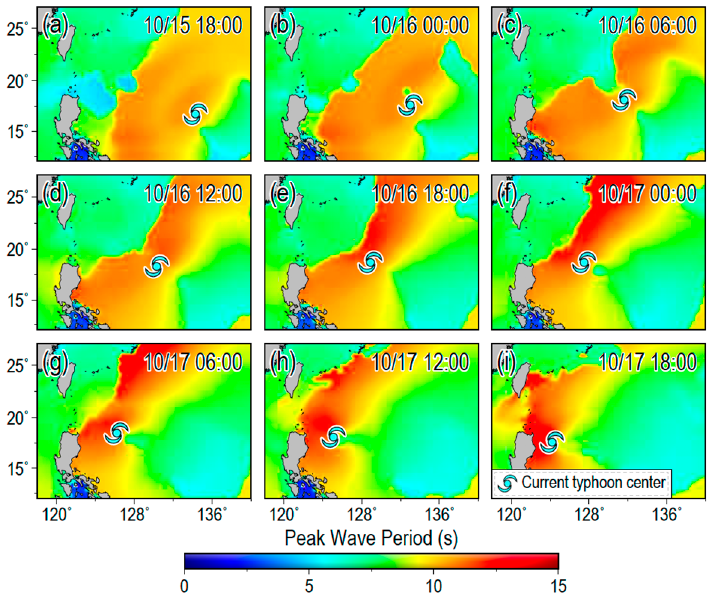
Figure 4. Analysis of the propagation and dispersion of ocean swells induced by Typhoon Megi. The distribution of peak periods of ocean waves in 6-h time intervals on 15–17 October 2010 ( a – i ) was predicted by ERA5 reanalysis from the European Centre for Medium-Range Weather Forecasts (ECMWF), and hurricane symbols indicate the location of the typhoon center at each time.